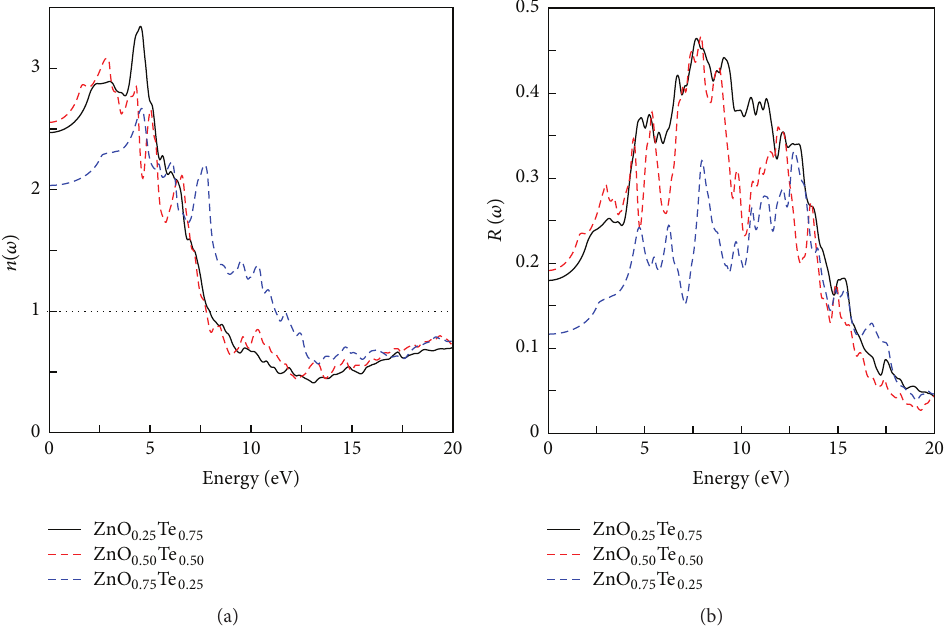
Figure 5: Frequency dependent (a) refractive index and (b)